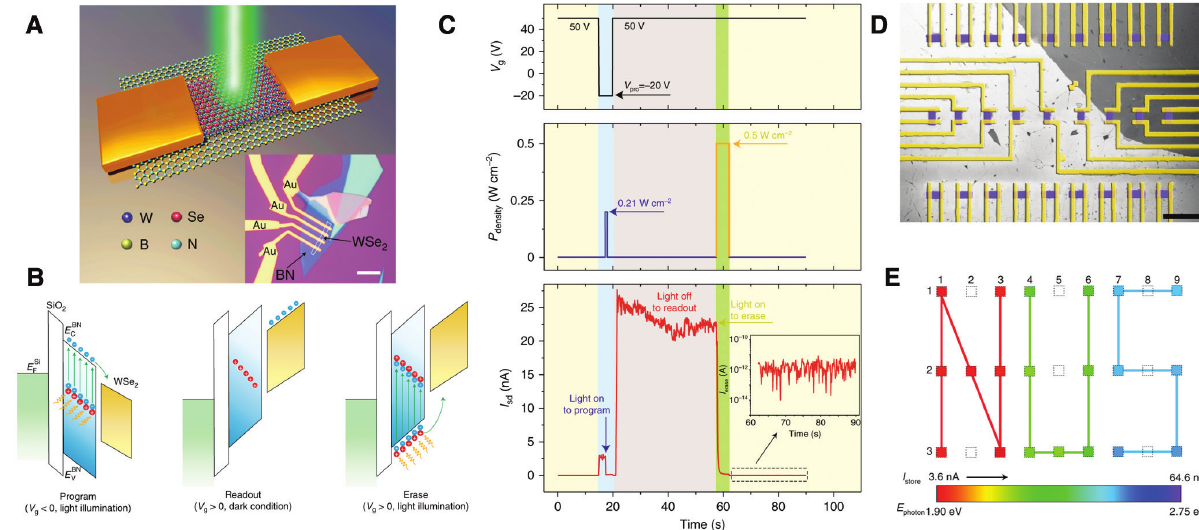
/BN heterostruture. Figure 5: Photonic memristor on a WSe 2 (A) Schematic illustration and the optical image of the WSe /BN heterostrucutre. (B) Schematic of the band diagrams of the WSe 2 memristor under programming (top), readout (middle), and erasing (bottom) processes. (C) A single program-readout-erase cycle of the WSe /BN memory. (D) False-coloured SEM image of an integrated WSe /BN 3 × 9 pixel matrix for colour image sensor. (E) The corresponding 2 2 schematic of the pixel matrix with selective exposure under three different wavelength lights (red 638 nm, green 515 nm, and blue 473 nm). (A–E) Reproduced with permission [37]. Copyright 2018, Nature Publishing